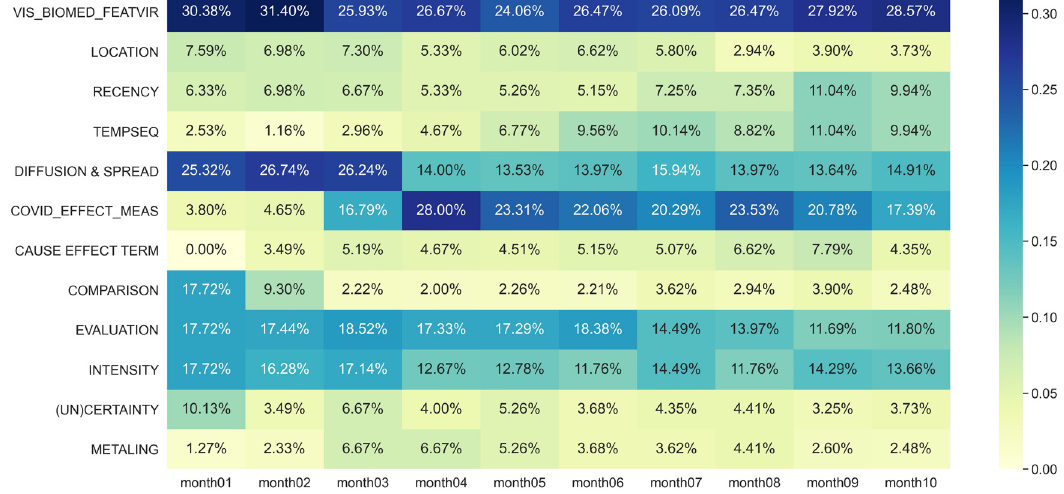
Figure 3: Heatmap of semantic category per month ( relative frequency ) , across all languages ( from month 01 = January to month 10 = October )